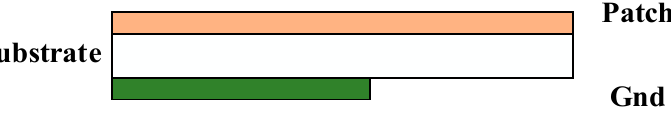
Figure 2. Side view of the antenna.